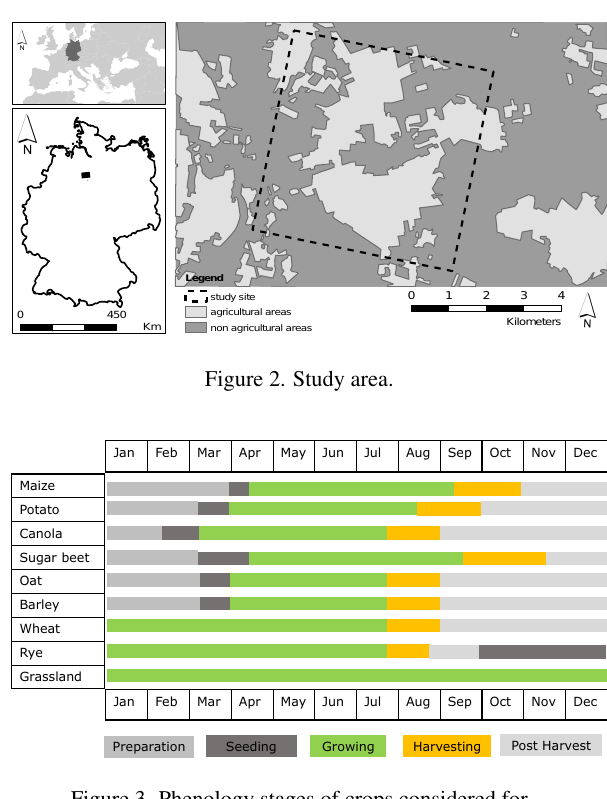
Figure 3. Phenology stages of crops considered for